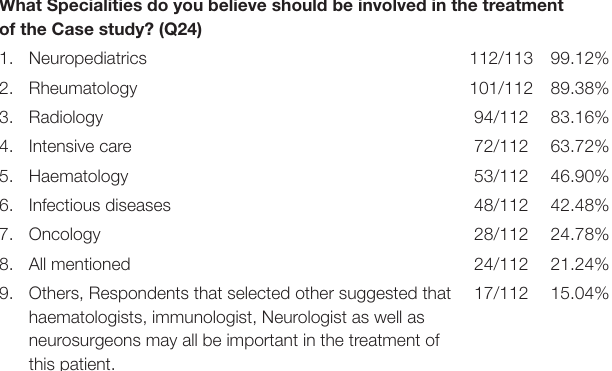
TABLE 5 | Specialities involved in the treatment of sv-cPACNS.